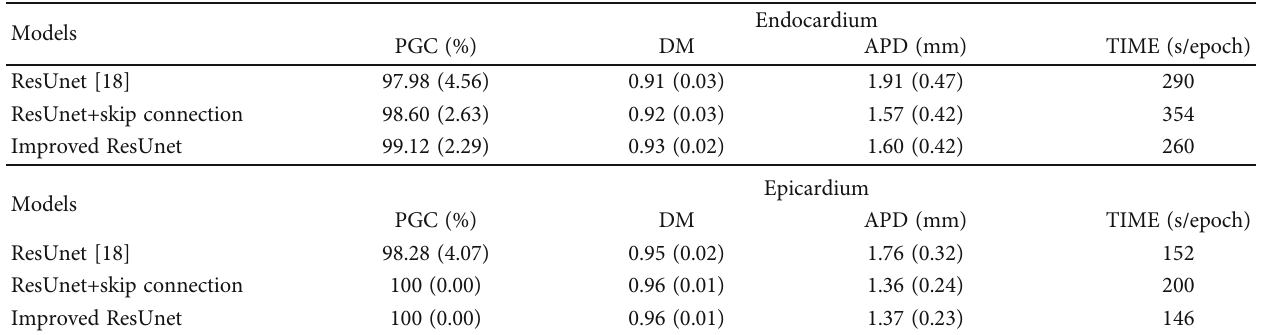
Table 3: Comparison of the e ff ects of skip connection and separable convolution on MICCAI 2009. Models